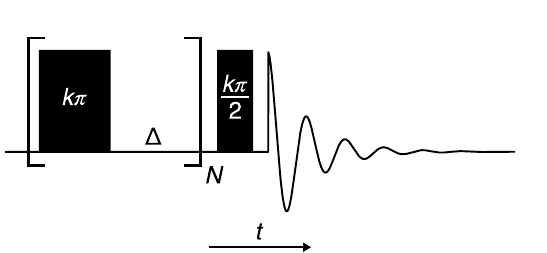
Figure 1. Experimental 7 Li NMR nutation curve for a lithium metal strip plotted with the numerical solution to Eq. 6. The lines fit to the experimental data (points) were calculated from Bloch simulations ( T 1 = 150 ms, T 2 = 600 μ s as measured for 7 Li metal and 20% dispersion in B 10 was assumed). The experimental flip angle is calibrated using LiCl(aq) ( τ π /2 = 38 μ s).